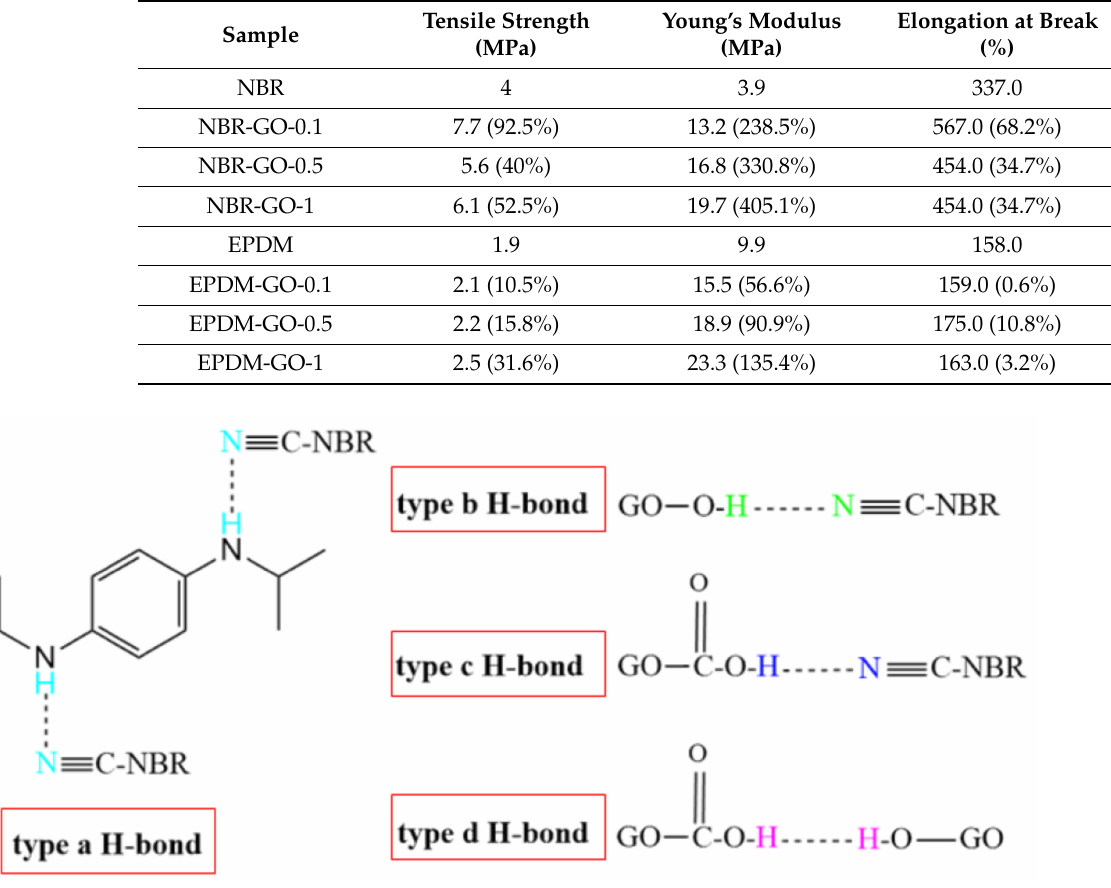
Table 3. Mechanical properties of NBR, EPDM and their nanocomposites [95].